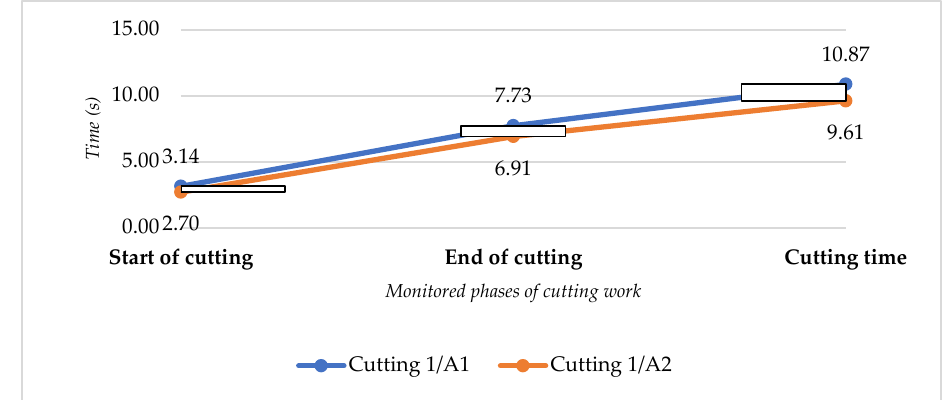
Figure 10. Summary of results (average) for the observed phases concerning the type “A” pillar cutting process.